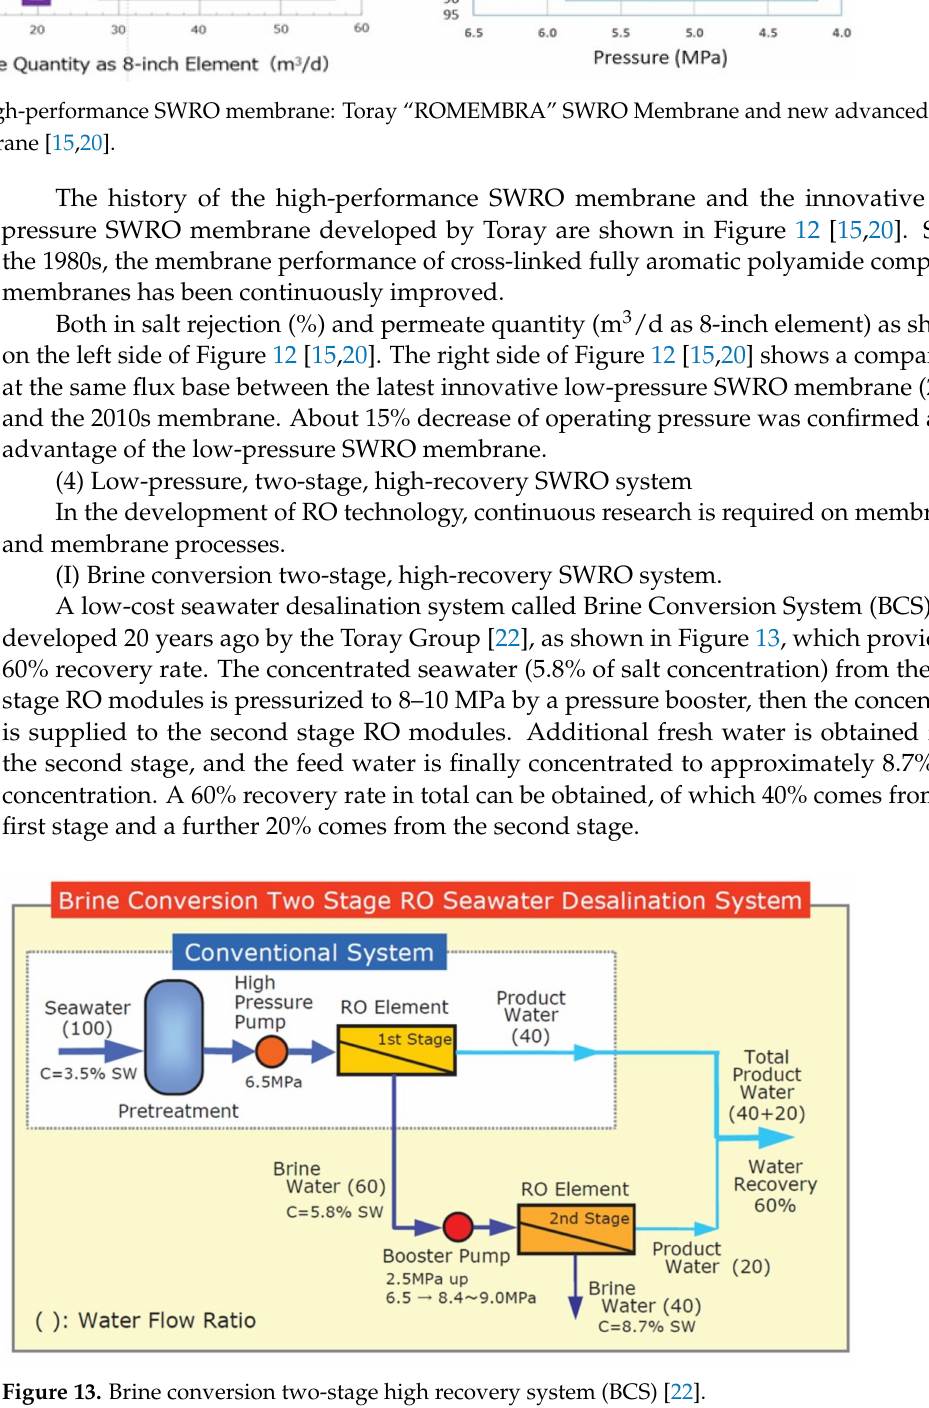
Figure 13. Brine conversion two-stage high recovery system (BCS)